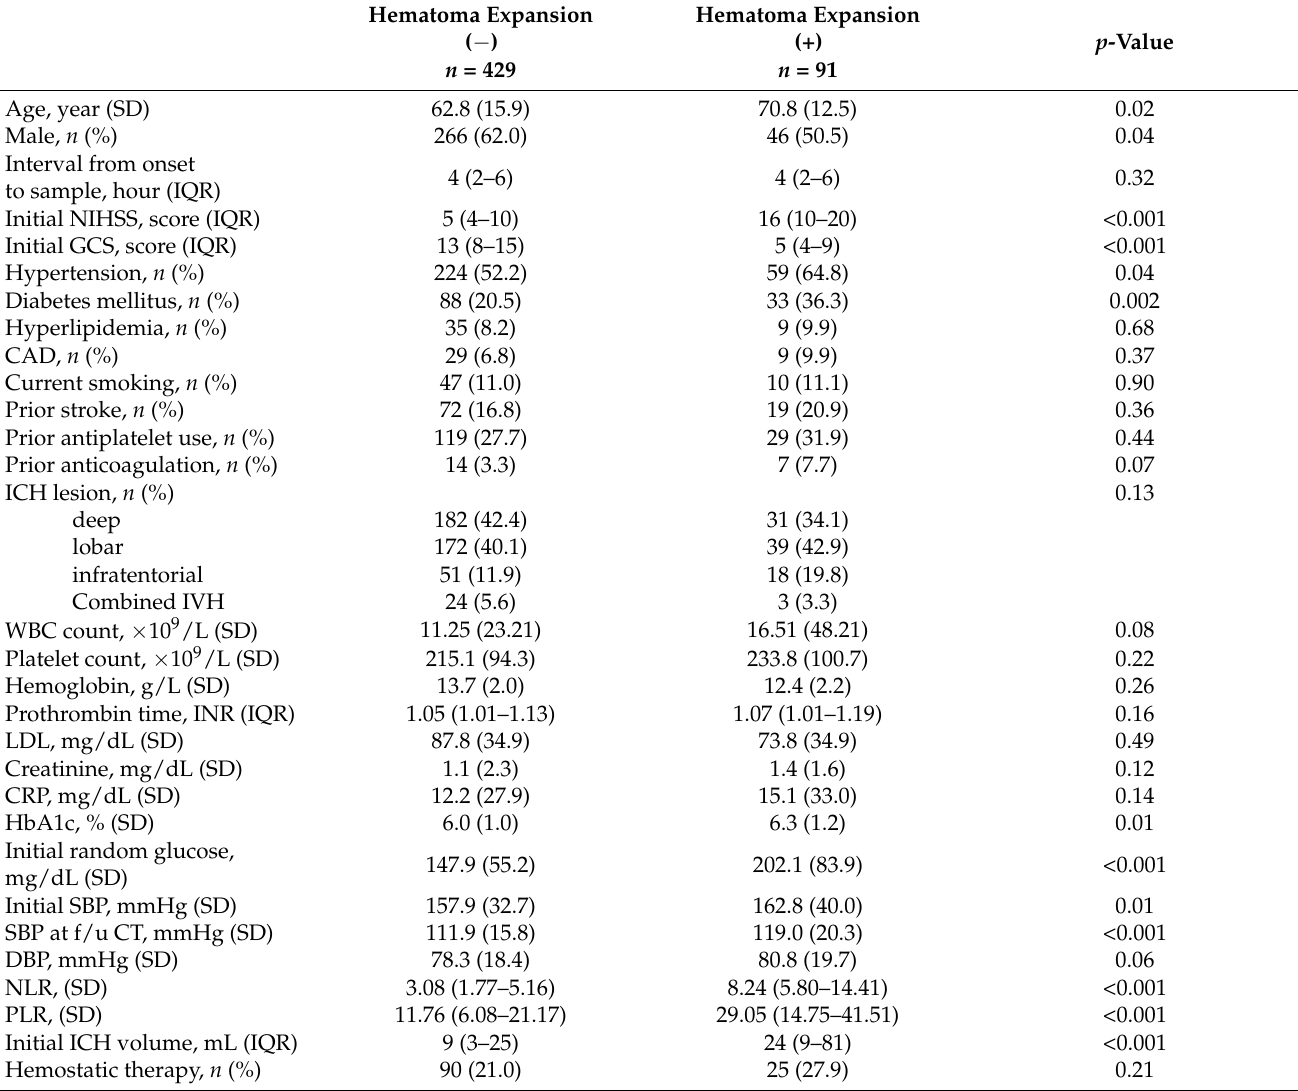
Table 1. Comparison baseline characteristics between HE and no-HE groups. Hematoma